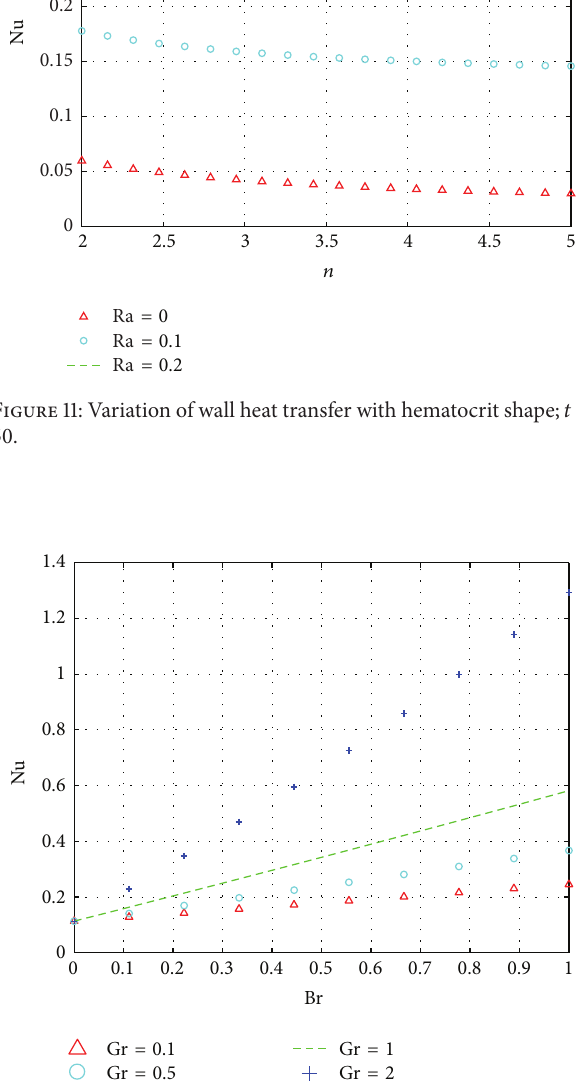
This leads to increases in the magnitudes of the temperature gradients at the wall and hence the observed increases in the wall heat transfer; see Figure 12. For each fixed Brinkman number, we again refer to the increase in the velocity with increasing Grashof number. This in turn similarly increases the magnitude of the viscous heating terms for each fixed value of the Brinkman number leading to the increased wall heat transfer shown in Figure